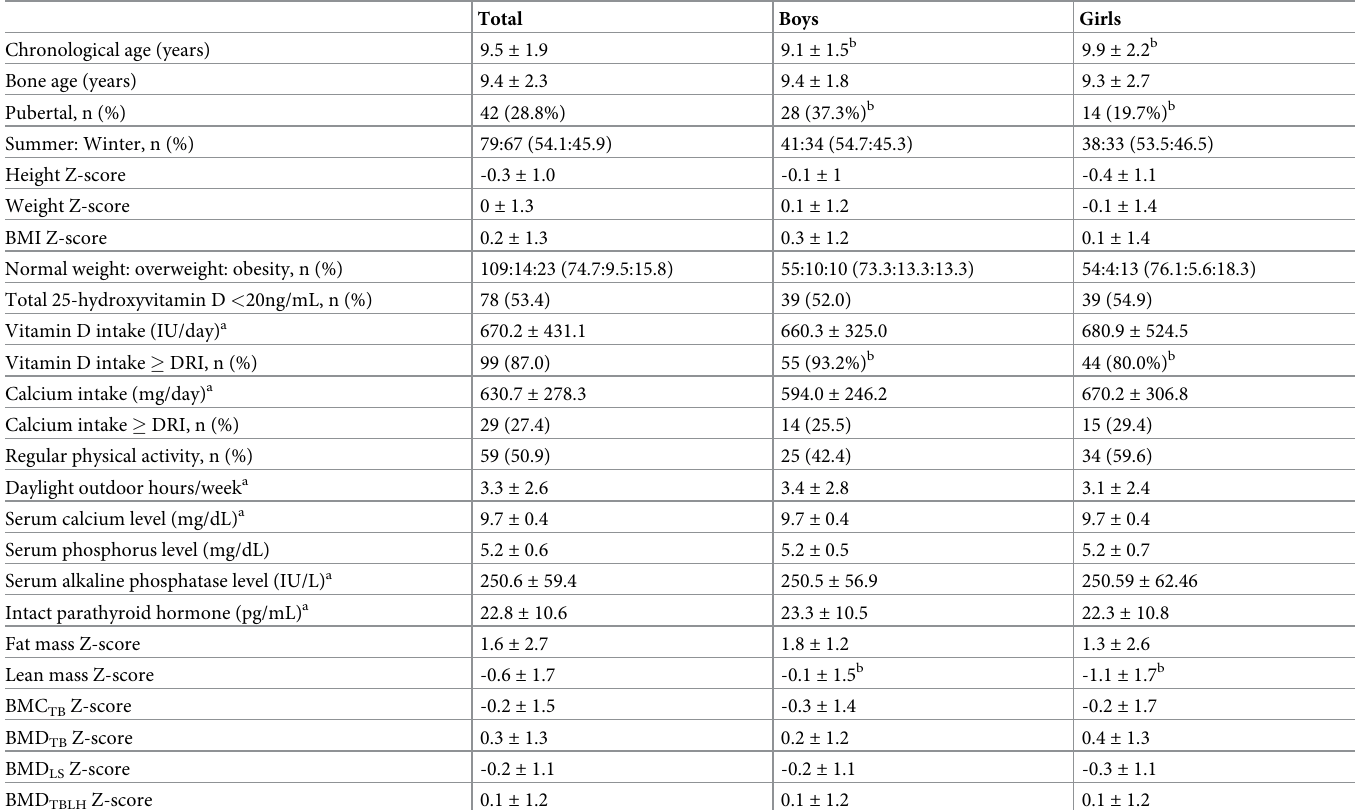
Table 1. Clinical characteristics of the